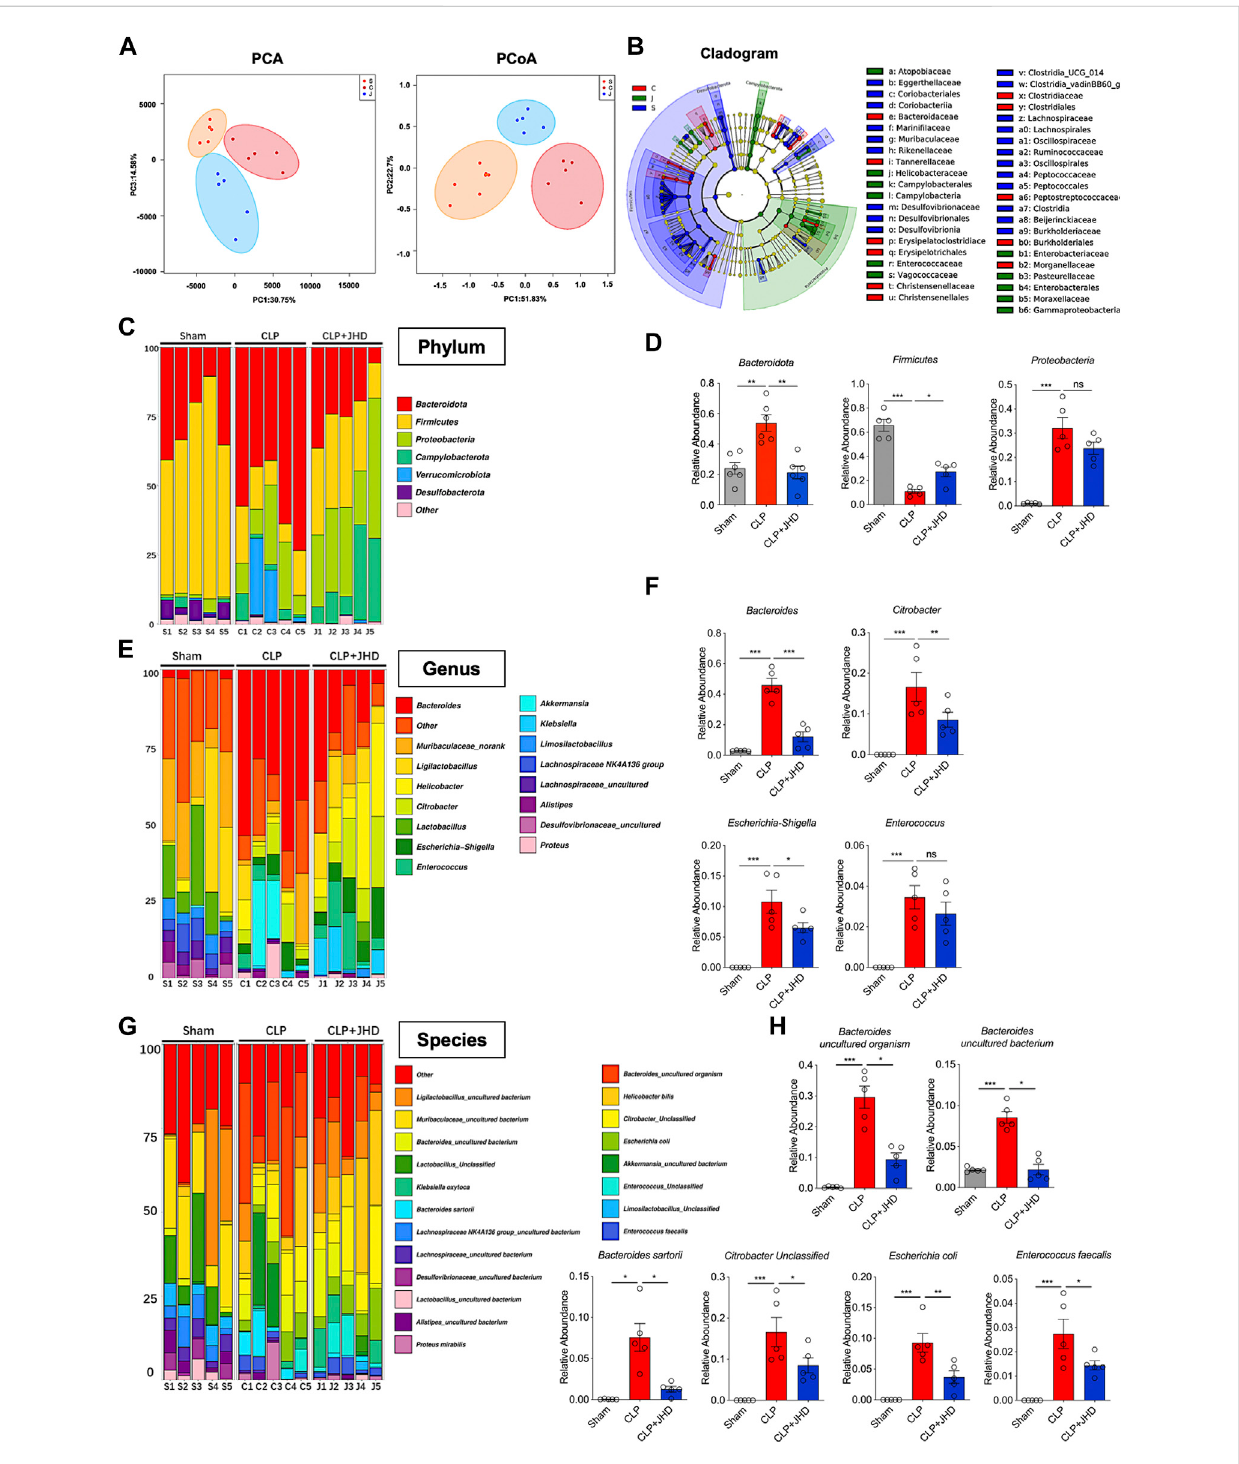
FIGURE 3 JHD modulates the composition of intestinal microbiome in sepsis mice. (A) Principal Component Analysis (PCA) and Principal Co-ordinates Analysis (PCoA)of gut microbiome. Orange, red and bluerepresents the sham(S), CLP (C) and CLP + JHD (J)groups, respectively; (B) Linear discriminant analysis Effect Size (LefSE) analysis. Deep blue, red and green represents the sham (S), CLP (C) and CLP + JHD (J) groups, respectively; (C) The composition of gut microbiome at phylum level, and (D) the representative bacteria with signi fi cant changes between the indicated groups ( Bacteroidota , Firmicutes and Proteobacteria ). (E) The composition of gut microbiome at genus level, and (F) the representative bacteria with marked changes ( Bacteroides , Citrobacter , Escherichia-Shigella, Enterococcus ); (G) The composition of gut microbiome at species level, and (H)